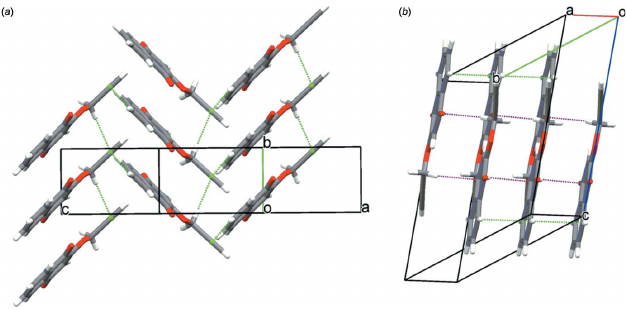
Figure 4 Partial packing diagrams of ( a ) the monoclinic form and ( b ) the triclinic from. Purple dashed lines represent the C—H (cid:2)(cid:2)(cid:2) O hydrogen bonds and green dashed lines the C—H (cid:2)(cid:2)(cid:2) (cid:2) and (cid:2) – (cid:2) interactions.